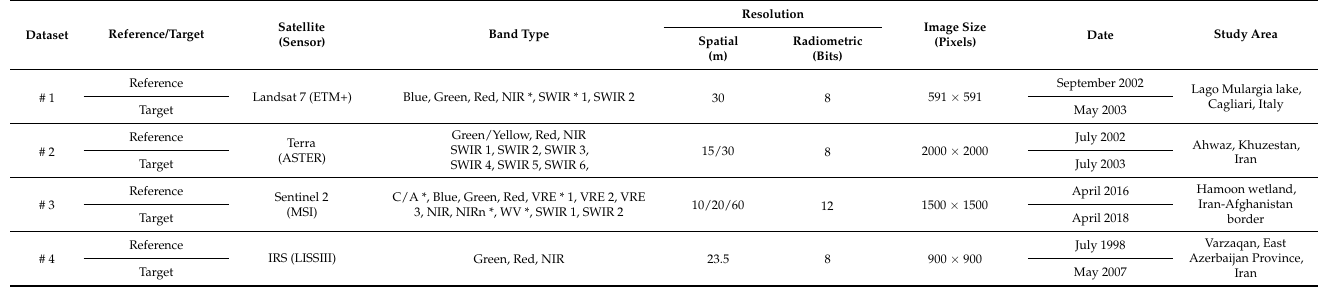
Table 1. Characteristics of the datasets used in this